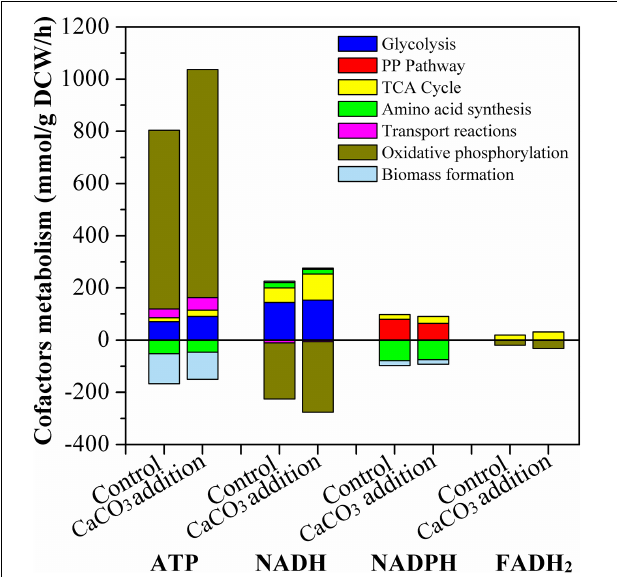
FIGURE 9 | Estimated production and consumption of ATP, NADH, NADPH, and FADH 2 by the E. coli W3110-BL without or with CaCO 3 addition. All data represent the average value of three estimation. For clarity, the error bars were not shown. The hydrolysis of ATP to ADP was not included in this